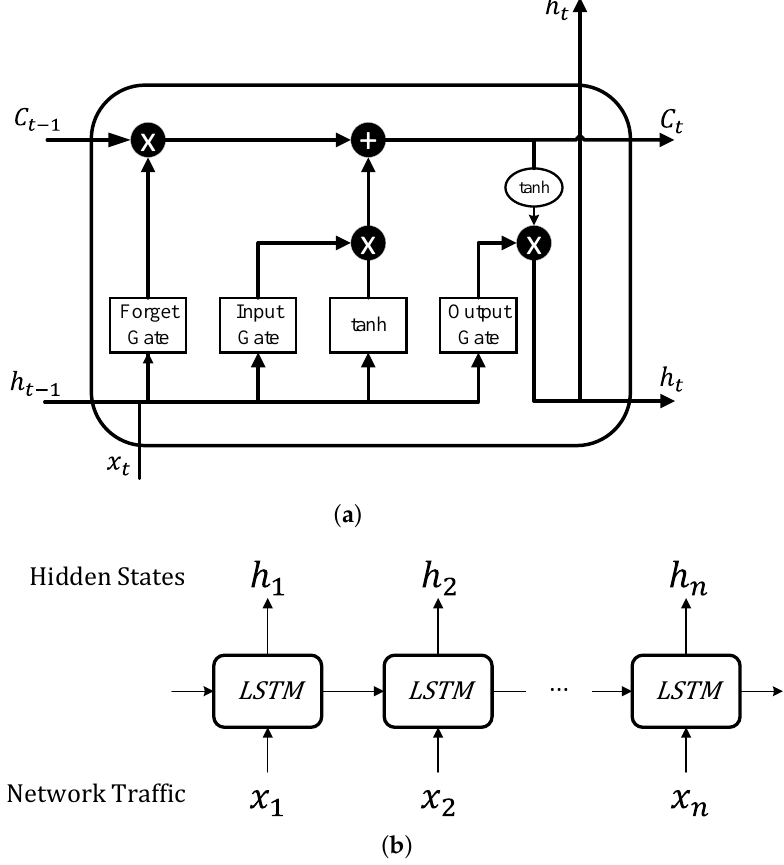
Figure 6. ( a ) The structure of a long short-term memory cell. ( b ) The structure of a long short-term memory neural network